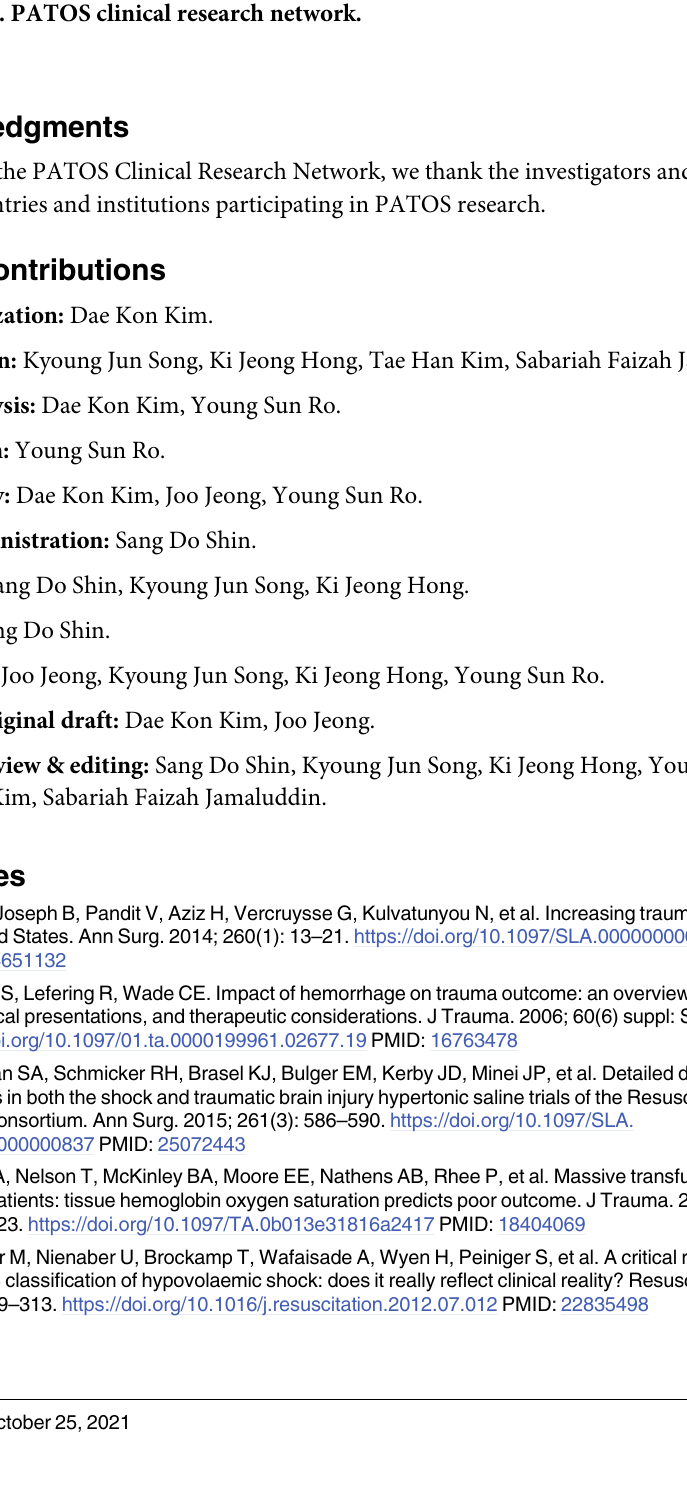
S1 Table. Association between exposure groups and outcomes in multivariate logistic regression. S2 Table. Association between exposure groups and outcomes according to prehospital shock index in multivariate logistic